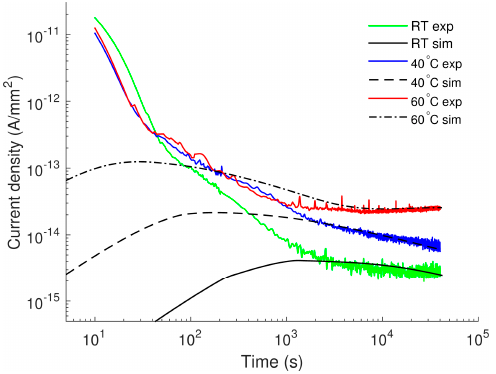
Figure 4. Current densities obtained from simulations (sim) and experiments (exp) on LDPE/Al 2 O 3 nanocomposite at various temperatures.